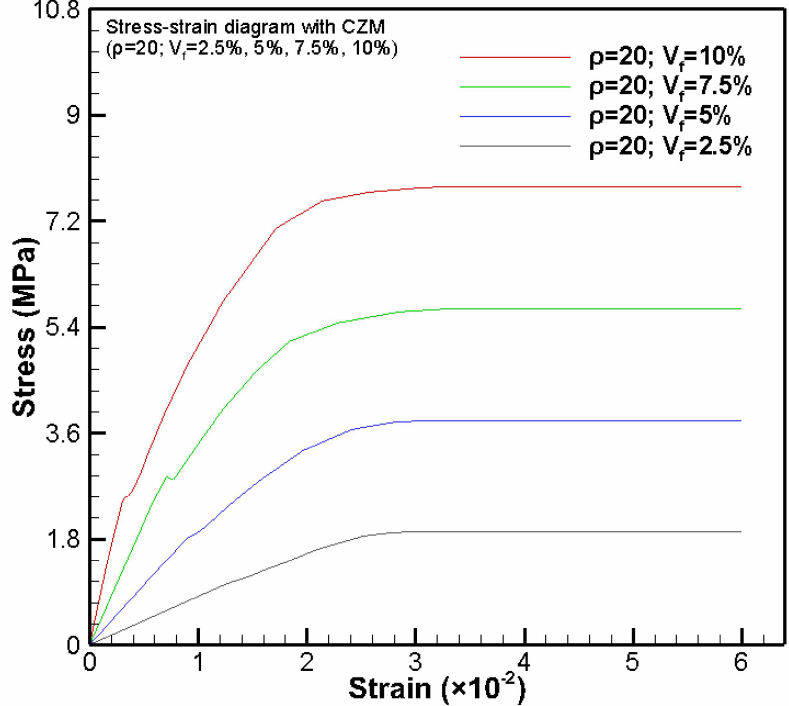
Figure 13. Effective stress-strain diagrams of the PNC (stack nanoparticle configuration) with CZM at the nanoparticle volume fraction of V f = 2.5%, 5%, 7.5%, and 10%, respectively ( ρ =